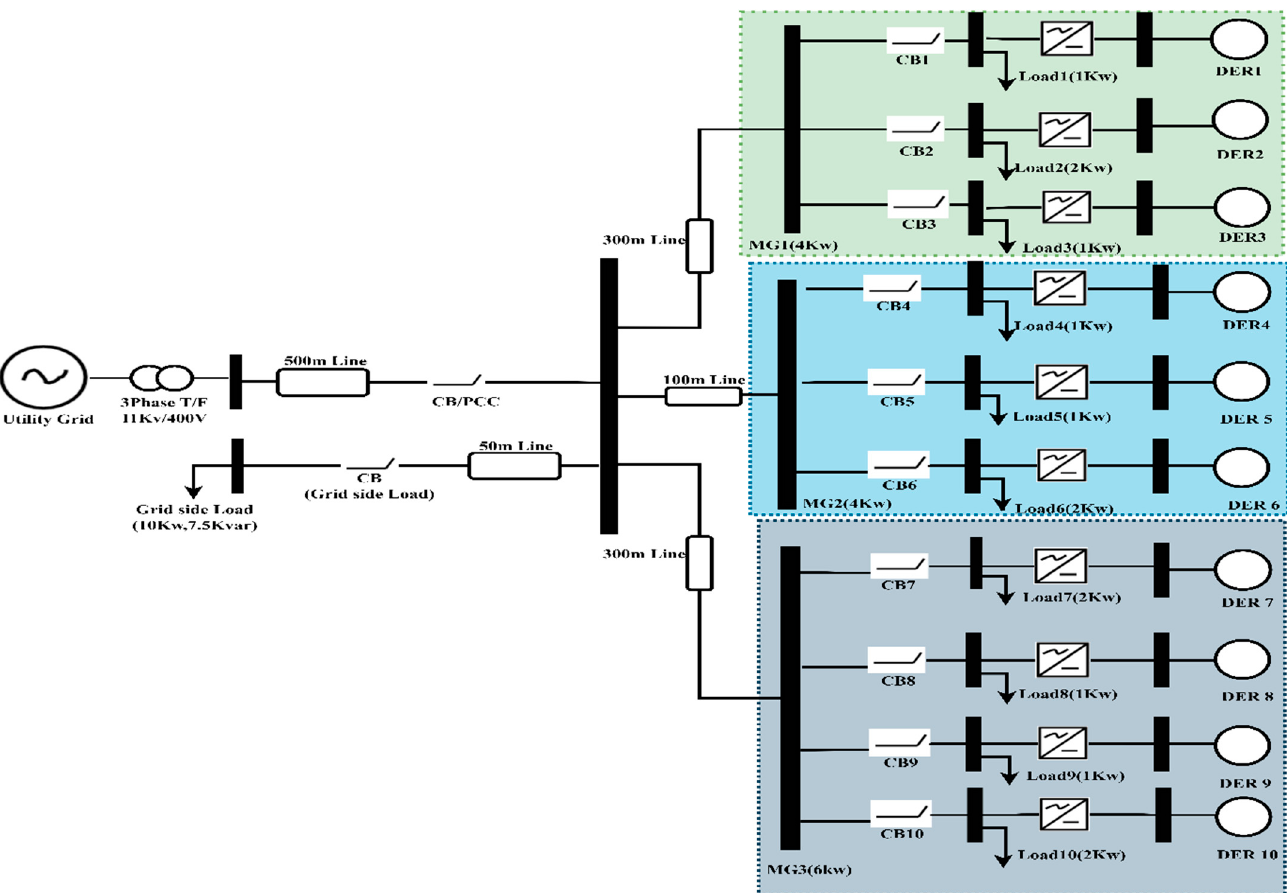
Figure 5. Complex MG assembly considering LI.